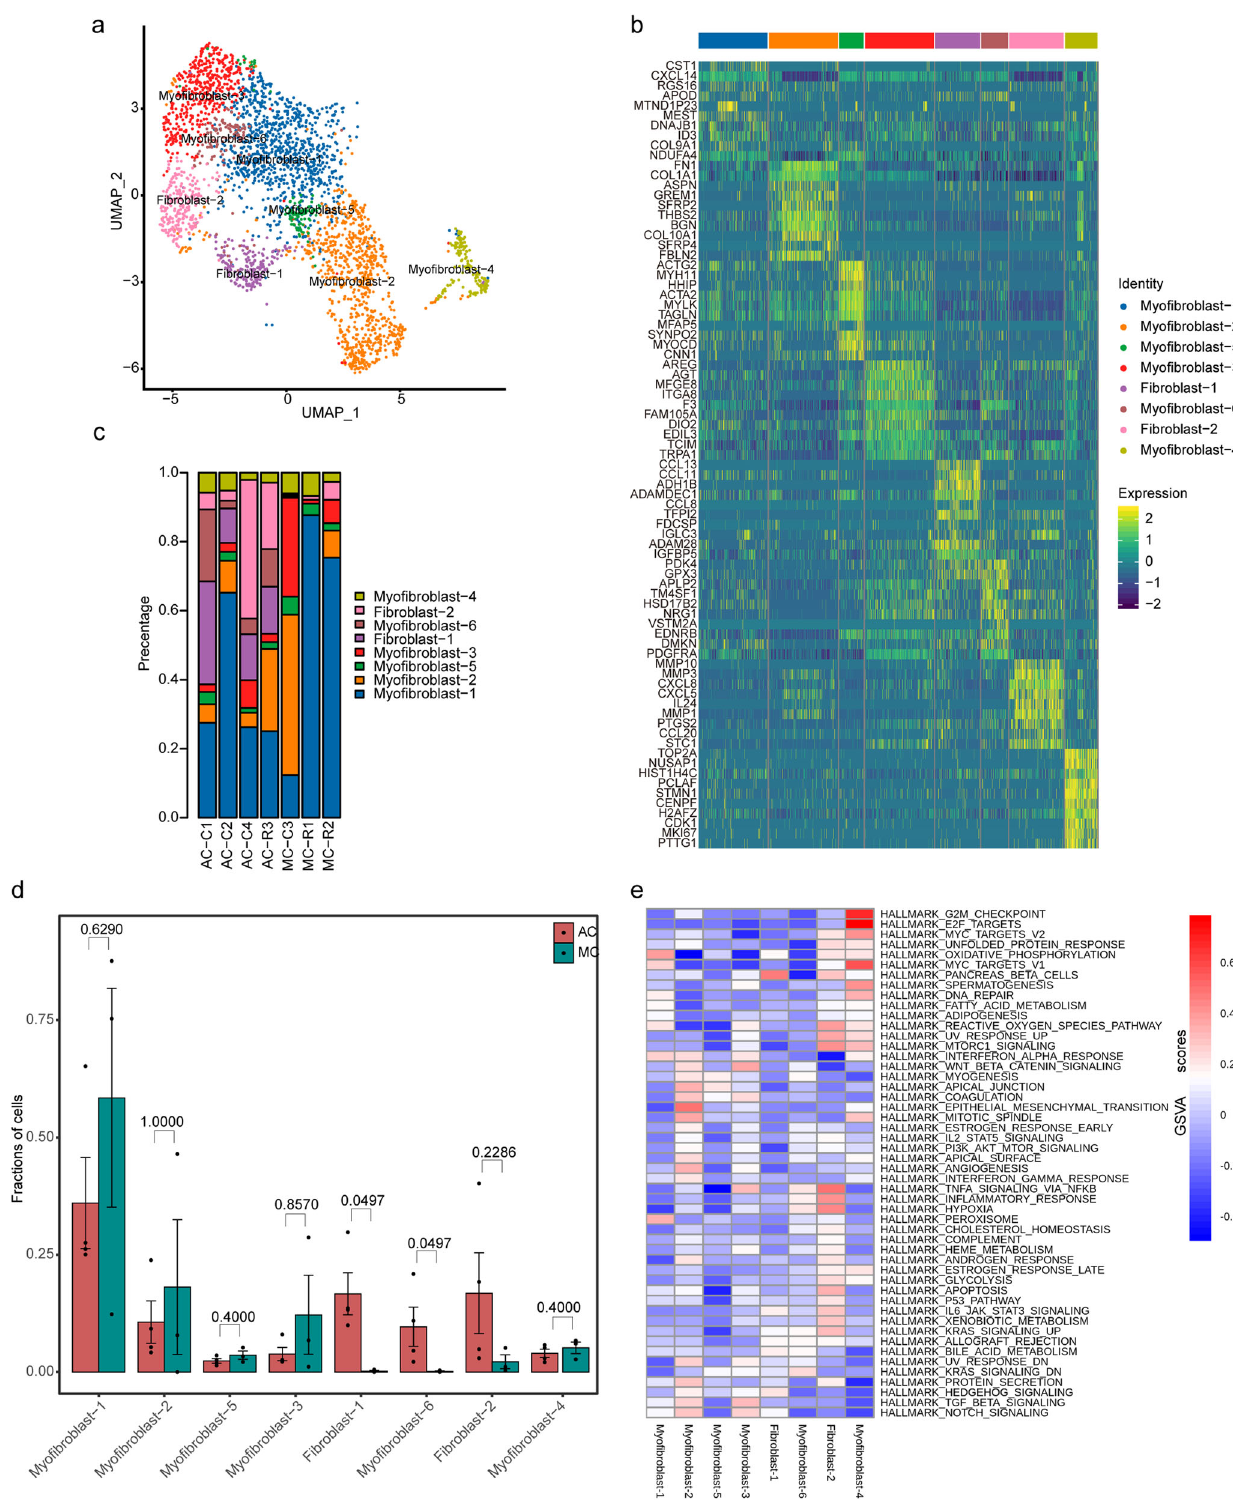
Fig. 9 Single-cell transcriptomic analysis of cancer-related fi broblasts (CAFs). a UMAP visualization of CAF clusters. b Top 10 genes expressed in 8 CAF cell subclusters. Colour key from blue to yellow represents the scaled expression levels of cell type-speci fi c marker genes from low to high. c Distribution of the 8 CAF clusters among 7 samples. d Histogram showing the proportions of CAF subclusters in ACs (red) and MCs (green). The analysis was performed using unpaired two-tailed Wilcoxon rank-sum tests, and statistical signi fi cance was set at p < 0.05. The error bars represent mean ± std. e Cluster heatmap of GSVA using 50 hallmark genes from MSigDB among the 8 CAF subclusters. Colour key from blue to red represents the GSVA scores from low to